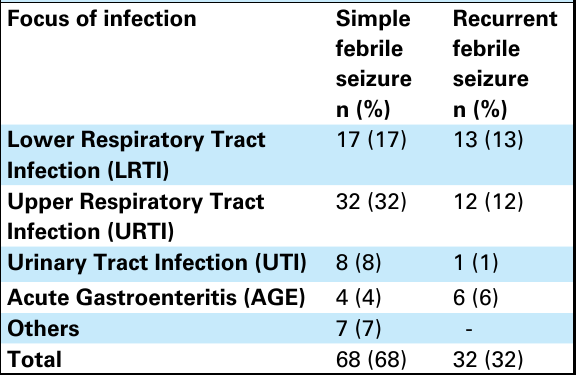
Table 1. Distribution of febrile convulsion according to the focus of infection (n= 100).